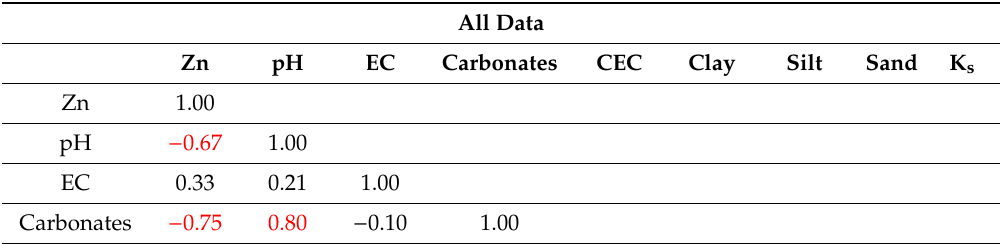
Table 6. Correlation matrices between the chemical properties, particle size distribution, and saturated hydraulic conductivity (correlation coe ffi cients marked red are statistically